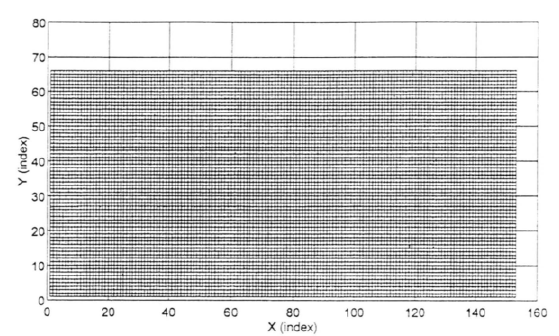
FIGURE 1 The original data point grid in the sense of scanning angle (66 x 153).